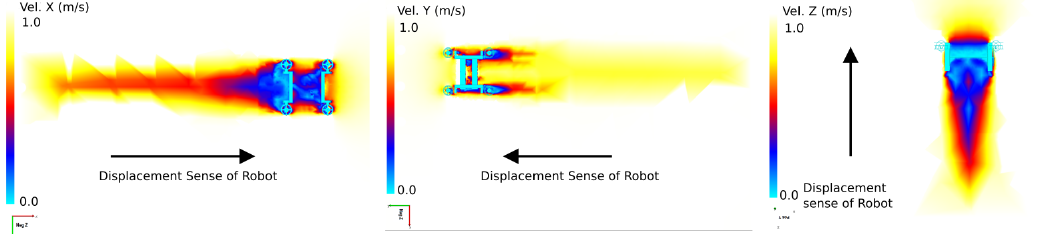
Figure 15. Three different results for the CFD simulation. On the left, velocity is shown in the X -axis. In the middle it is shown in the Y -axis and on the right in the Z -axis. These results were obtained at 1 m . The dark blue zones are values close to 0 m s